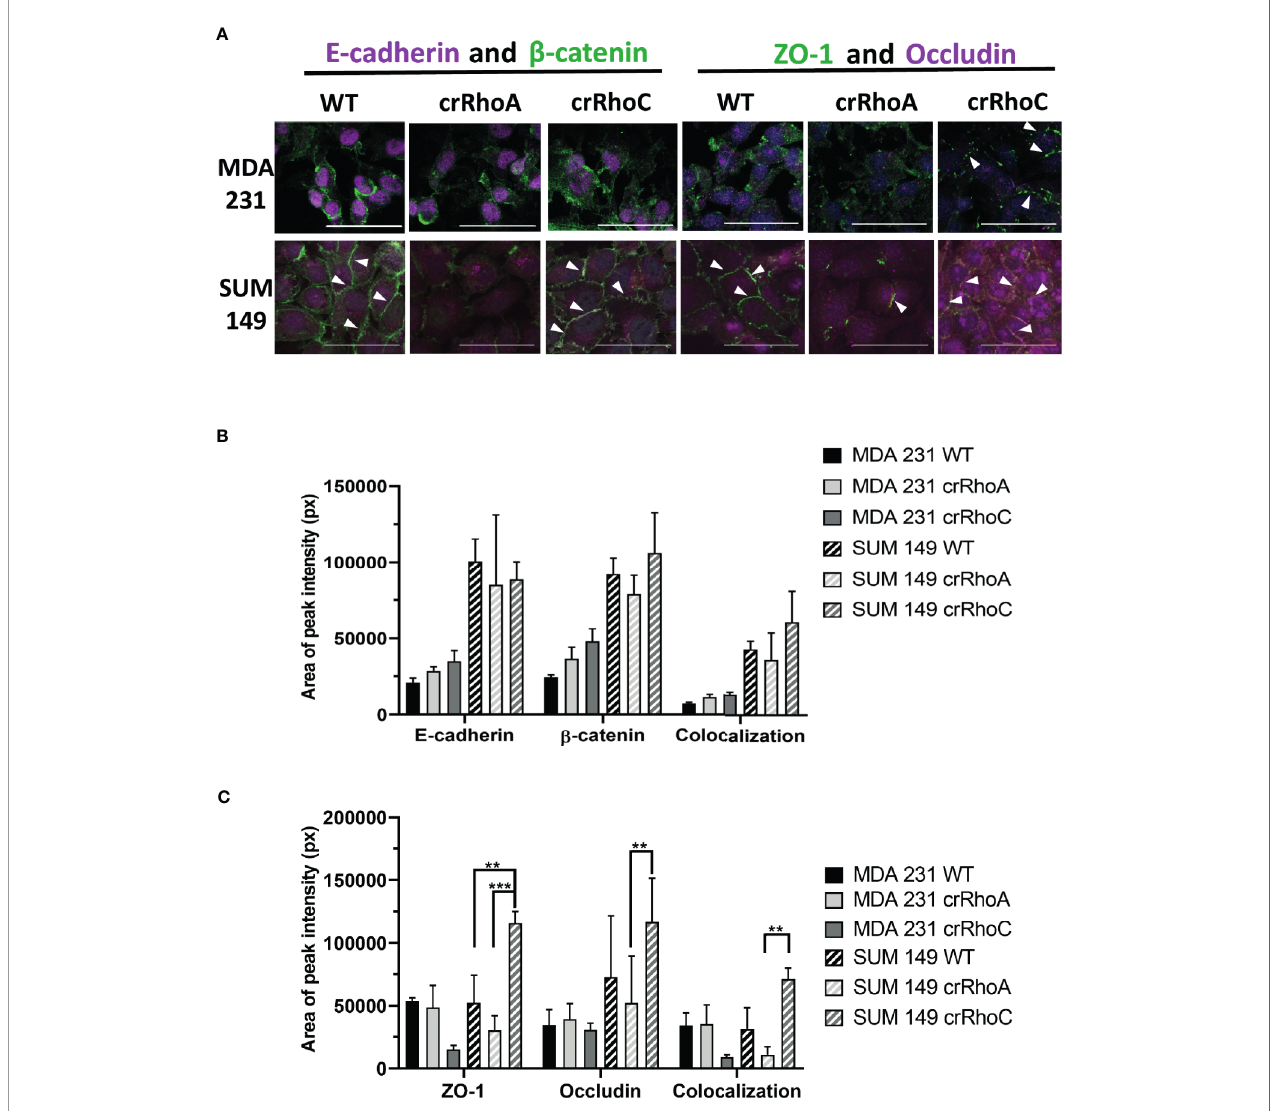
FIGURE 2 | Rho expression changes junction marker localization to cell-cell borders. (A) Representative images of immuno fl uorescence staining of junction markers in wild-type, crRhoA, and crRhoC cells. White arrows point to areas of junction marker localization to cell-cell borders. Scale bars = 50 m m. Quanti fi cation from 3 fi elds of view per cell type of (B) adherens junction marker and (C) tight junction marker localization to cell-cell borders in wild-type, crRhoA and crRhoC cells, with area of peak intensity corresponding to areas of cell-cell border localization. Solid bars are MDA 231, striped bars are SUM 149; black bars are wild type, light grey bars are crRhoA cells, and dark grey bars are crRhoC cells. **p < 0.01; ***p <